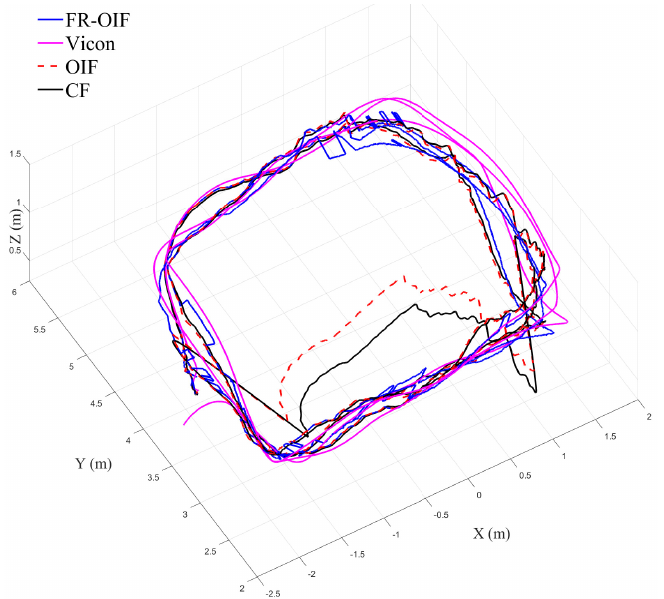
Figure 5. Variation of estimated MAV trajectory obtained from Centralized Fusion (CF), decentralized Optimal Information Fusion (OIF), Fault Resilient (FR)-OIF, and ground truth (position from vicon camera). FR-OIF provides the estimated position of the MAV approximately close with the ground truth obtained from the Vicon motion capture system.